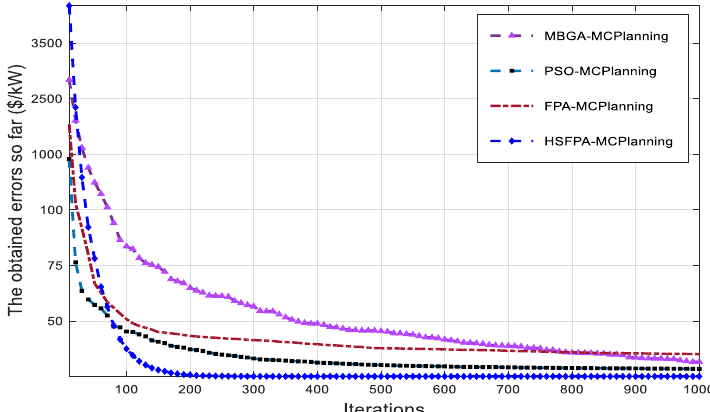
Figure 8. The planned curve results of the schemes of the HSFPA, MBGA, PSO, and AOA methodologies according to the daily schedule.